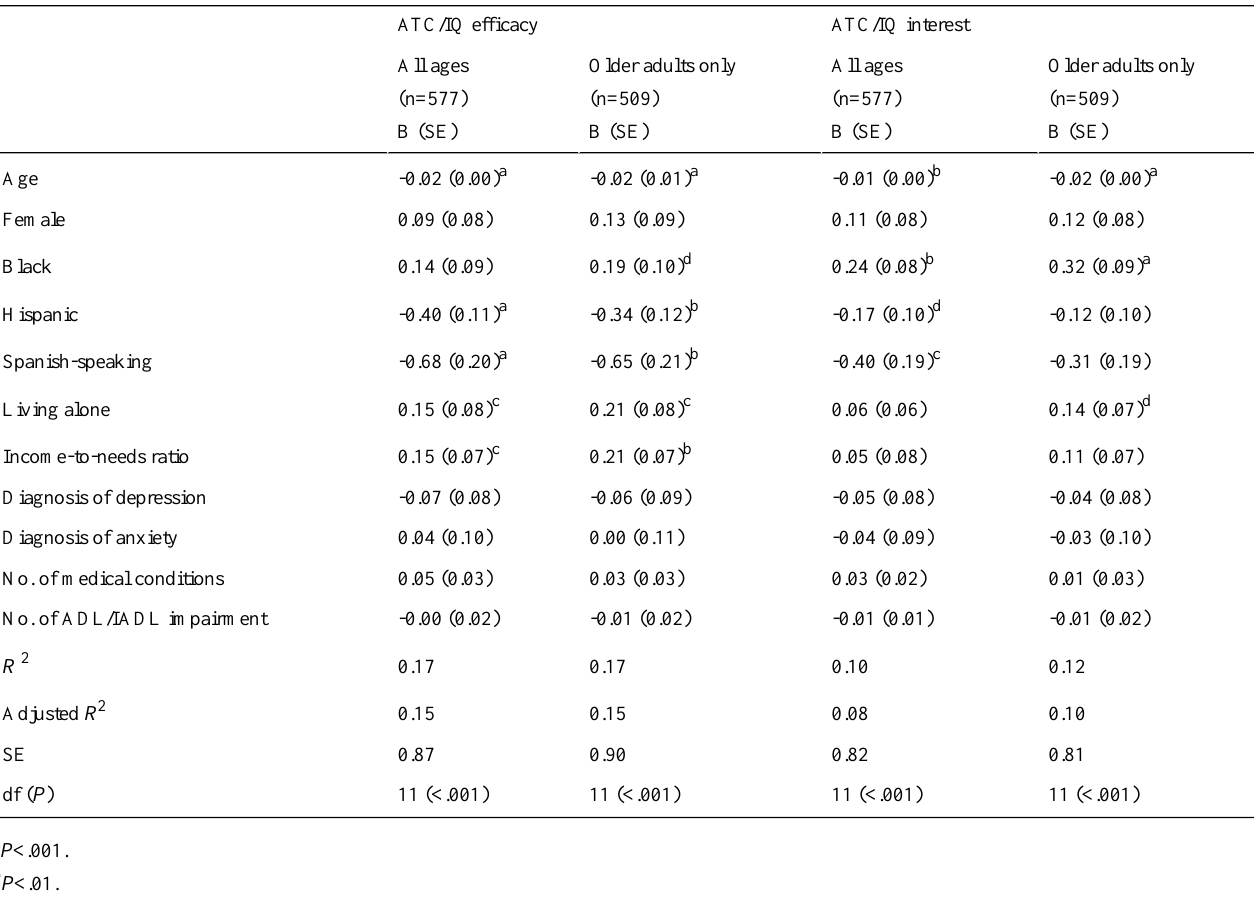
Table 7. Correlates of ATC/IQ efficacy and interest among those who never used the Internet.